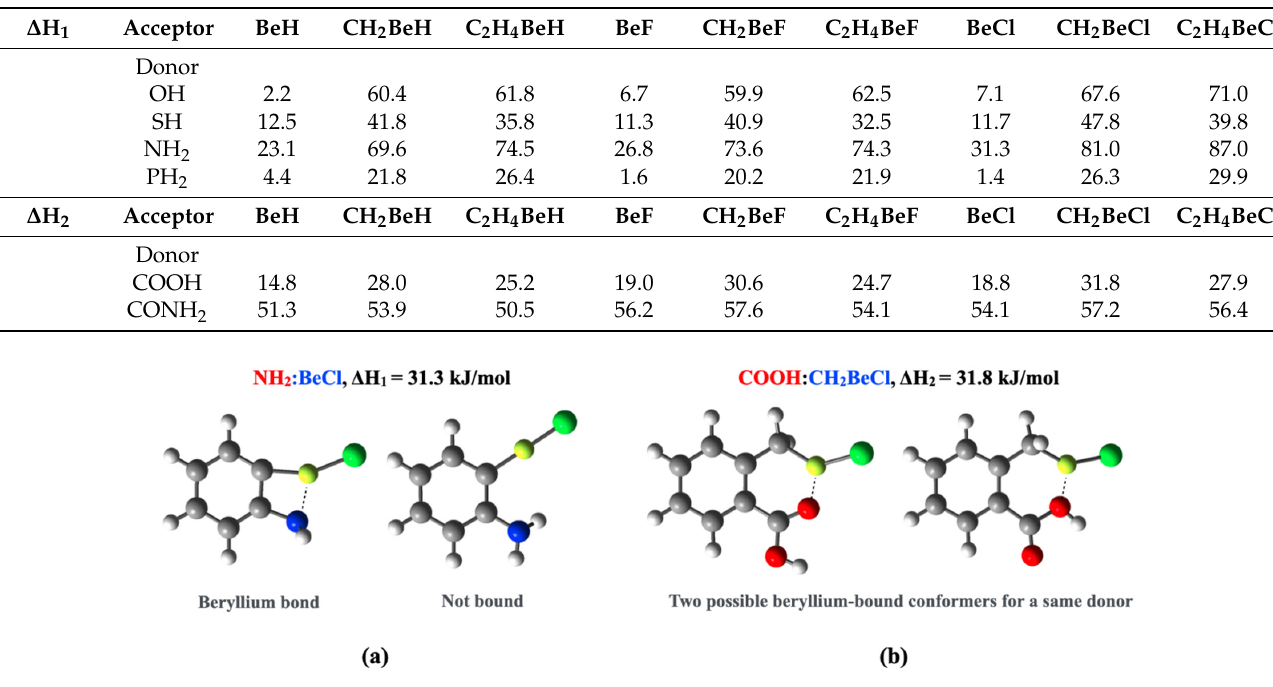
Figure 1. ( a ) Meaning of enthalpy ∆ H 1 taking NH 2 :BeCl as a suitable example. Enthalpy ∆ H 1 gives the stabilization provided by the formation of a beryllium bond. ( b ) Meaning of enthalpy ∆ H 2 taking COOH:CH 2 BeCl as a suitable example. Enthalpy ∆ H 2 gives the energy difference depending on the binding site for a same donor. The color code for the atoms is the following: hydrogen: white; carbon: grey; nitrogen: blue; oxygen: red; chlorine: green; and beryllium: yellow.